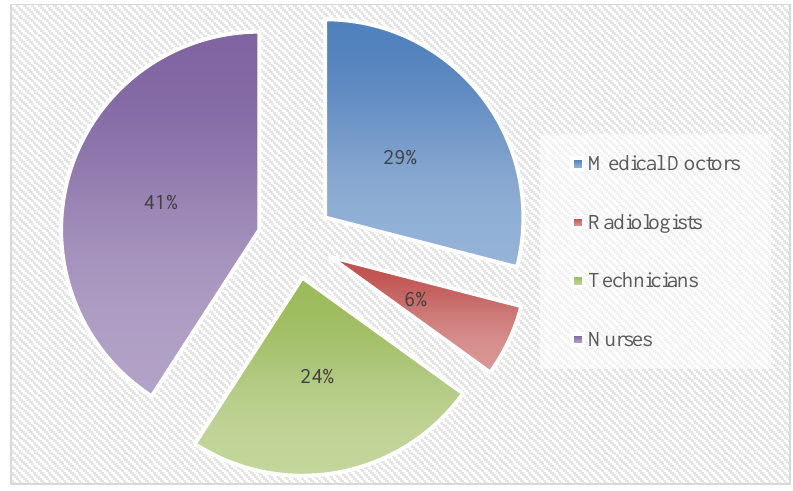
Figure 3. Number of participants in the survey and their fields